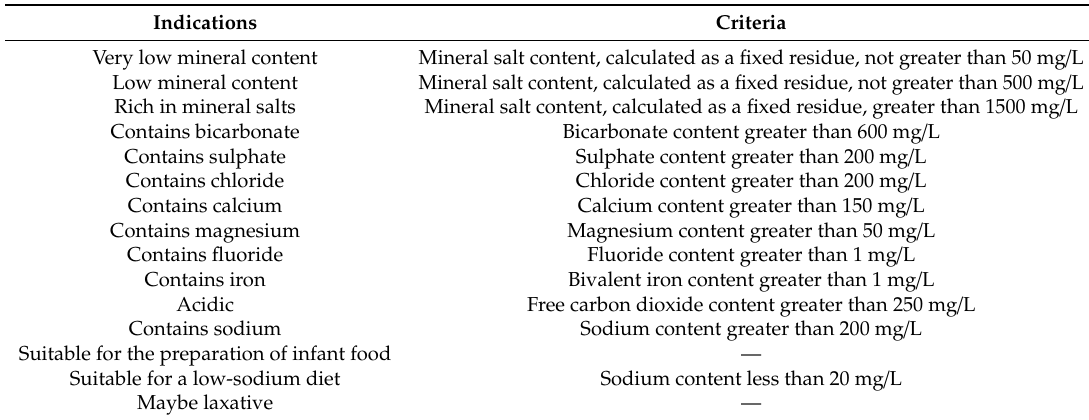
Table 1. Indications and criteria laid down in article 9(2) of 2009 / 54 / EC